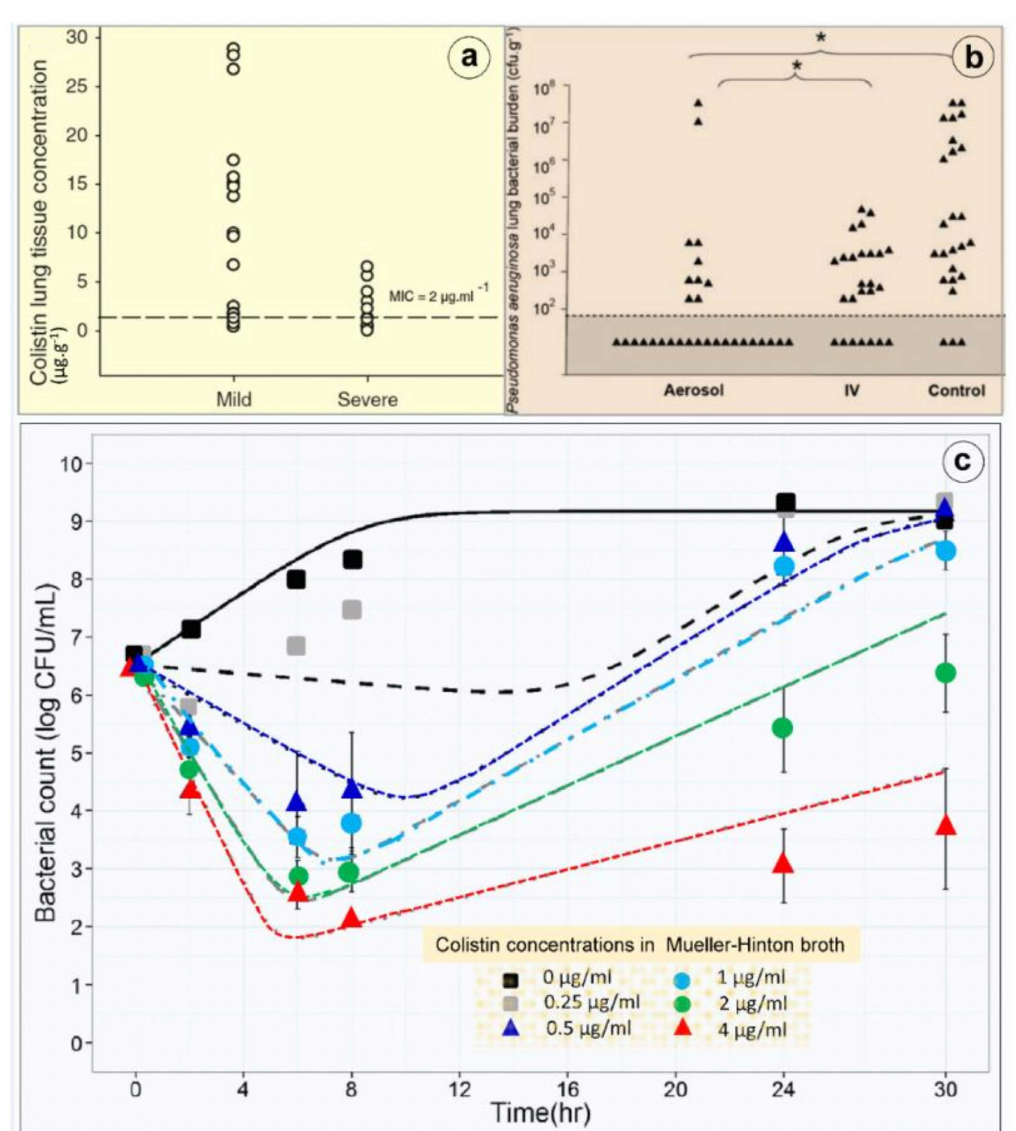
Figure 8. Lung deposition and bactericidal effects of high-dose nebulized colistimethate sodium. ( a ) Colistin concentrations measured in multiple post-mortem subpleural lung specimens in a series of six anesthetized and mechanically ventilated piglets with inoculation pneumonia caused by Pseudomonas aeruginosa. Colistin concentrations were measured by high- performance liquid chromatography in 17 pulmonary segments with mild pneumonia and moderate loss of lung aeration and in 13 pulmonary segments with severe pneumonia and complete loss of lung aeration (infectious consolidation). The dashed line indicates the minimal inhibitory concentration of the inoculated Pseudomonas aeruginosa [42]. ( b ) Lung bacterial burden of Pseudomonas aeruginosa measured in post-mortem lung segments in sixteen piglets with massive inoculation pneumonia caused by Pseudomonas aeruginosa. Six received three nebulizations of 100,000 IU/kg colistimethate sodium at 12 h intervals (aerosol), six received four intravenous administrations of 40,000 IU/kg at 8 h intervals (IV) and four did not received any antibiotic (control). Quantitative lung bacteriology was measured in lung segments (triangles) sampled 1 h after the third aerosol in the aerosol group and after the fourth infusion in the intravenous group (IV) and 49 h after the bacterial inoculation in the untreated control group. The grey area indicates the lower limit of quantification for bacterial counts. Asterisk at the top of the figure indicates the statistically significant difference existing between the percentage